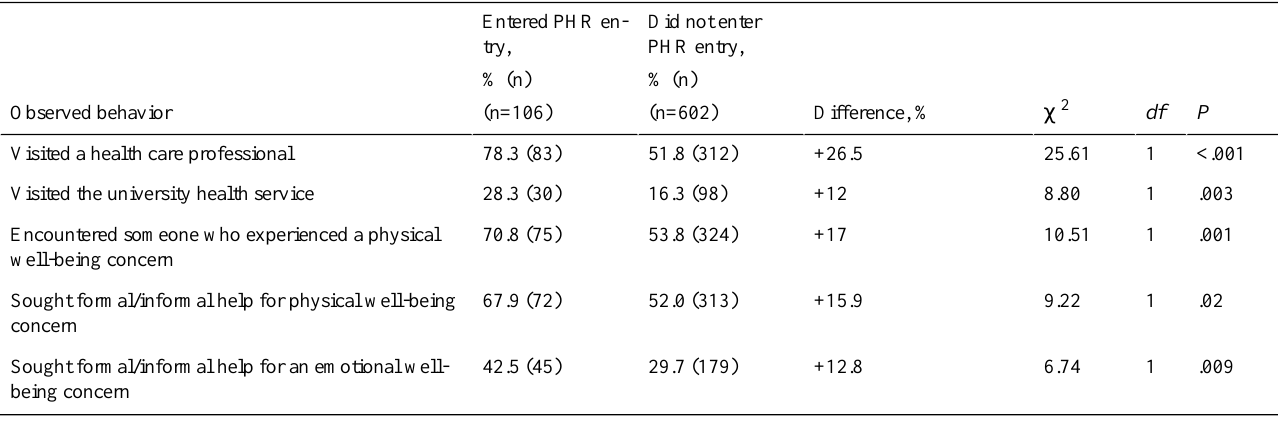
Table 5. Personal health record (PHR) users versus